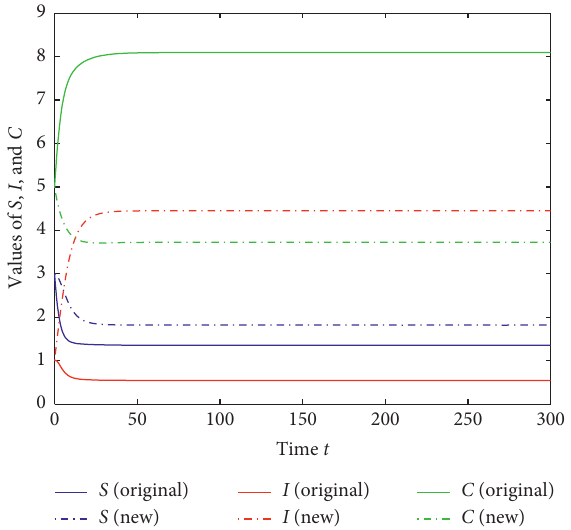
Figure 2: A comparison between the new proposed SICS model and the original SICS model.